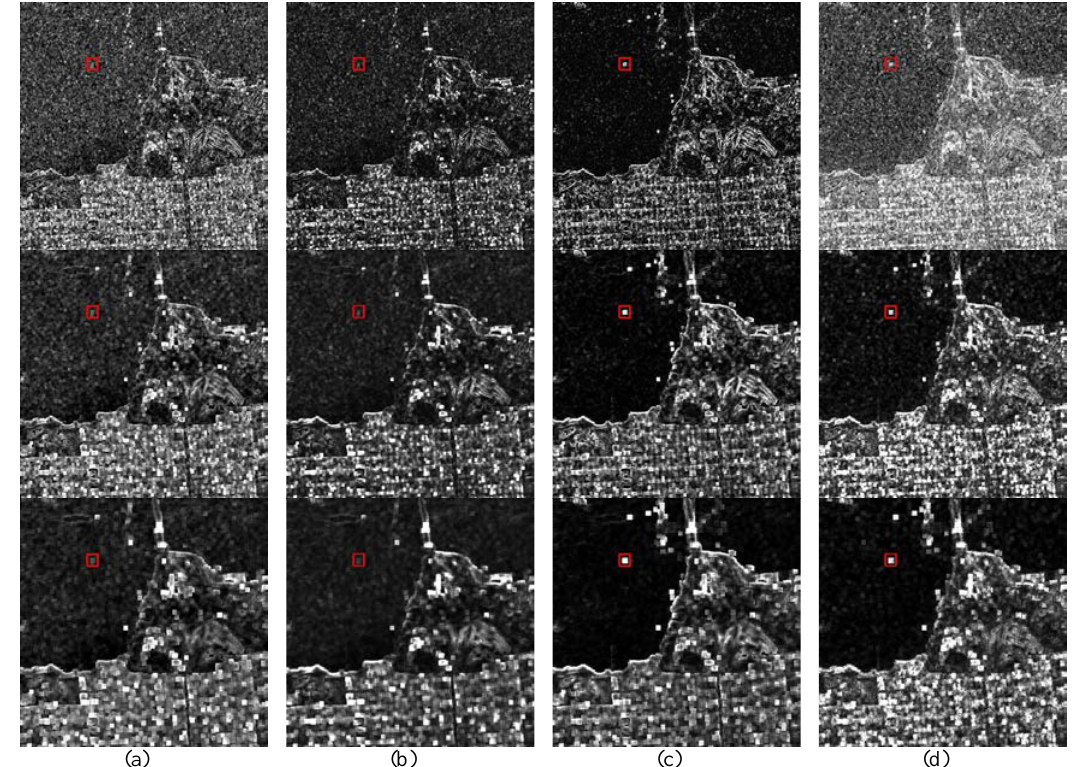
Figure 2. Comparison of the heterogeneity feature on AIRSAR data. From top to bottom are the heterogeneity images with ranging from 3 × 3 to 7 × 7. (a) CV; (b) A/G; (c) shape parameter; (d) the proposed